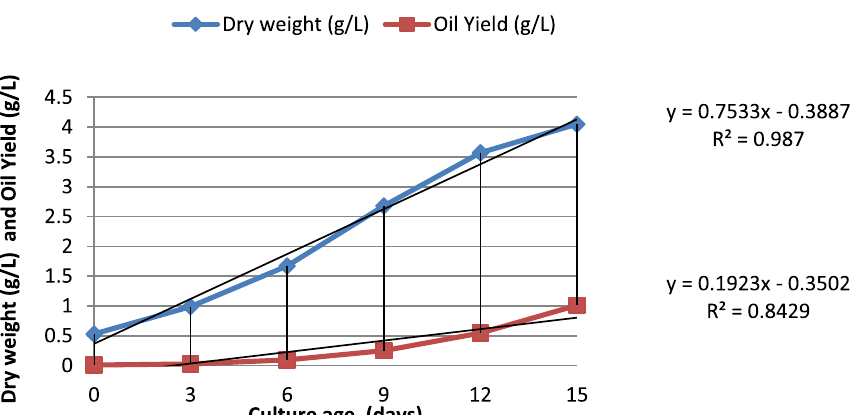
Fig. 3 Dry weight and Oil yield of Pseudochlorella pringsheimii grown in photobioreactor (2000 L) undeer nitrogen, and Phosphours deficient and high concentration of Iron and corbon